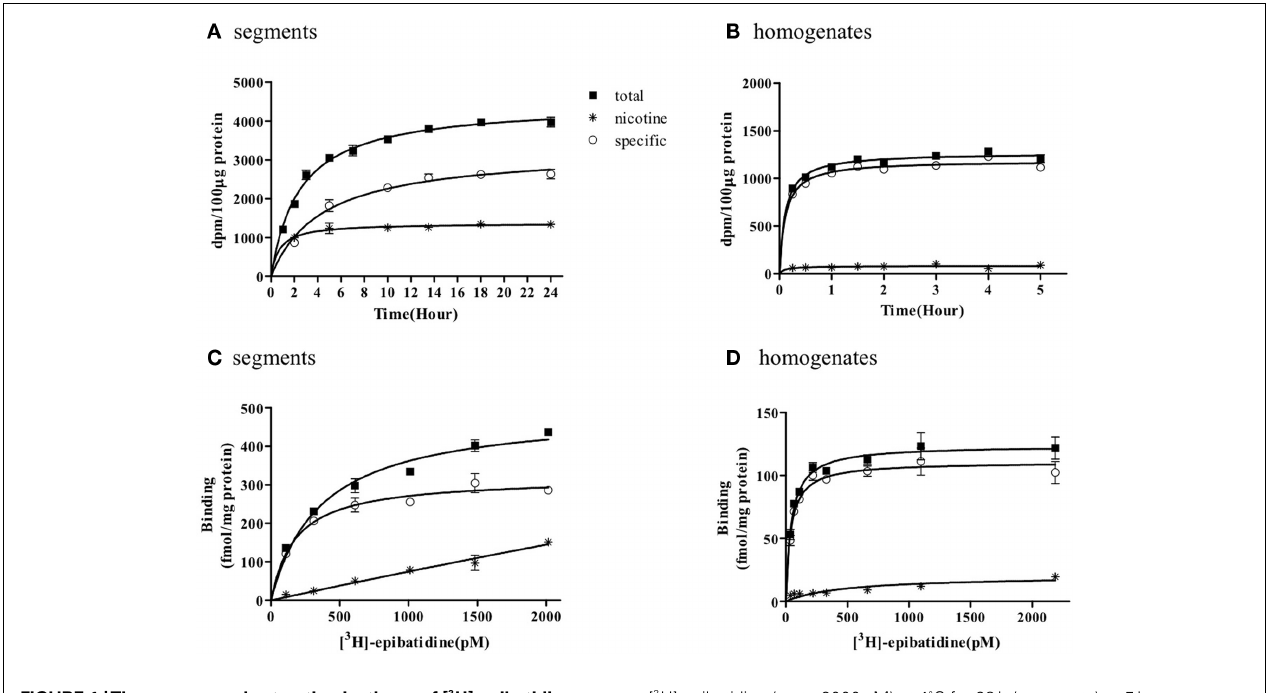
[ 3 H]-epibatidine (up to 2000pM) at 4˚C for 28h (segments) or 5h (homogenates). Specific binding (open circles) was determined by subtracting the amount bound in the presence of 100 μ M nicotine (asterisks) from total binding (closed squares). Each point represents the mean of duplicate determinations. Each figure represents four to five